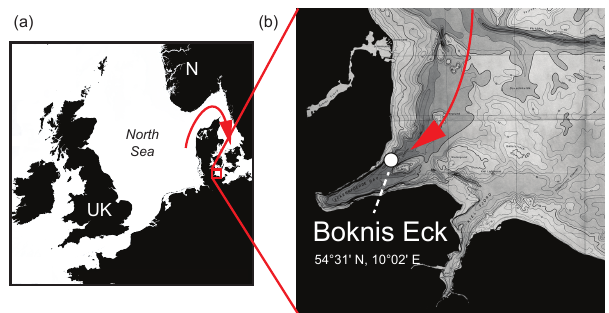
Figure 1. Map of the North Sea and the western Baltic Sea with a close-up of the study area. (a) Overview map of the western Baltic Sea including the Kattegat, the Skagerrak and parts of the North Sea. (b) Close-up of the study area with the sampling site (time- series station Boknis Eck) marked with a white dot. Red arrows indicate sporadic inflow of North Sea